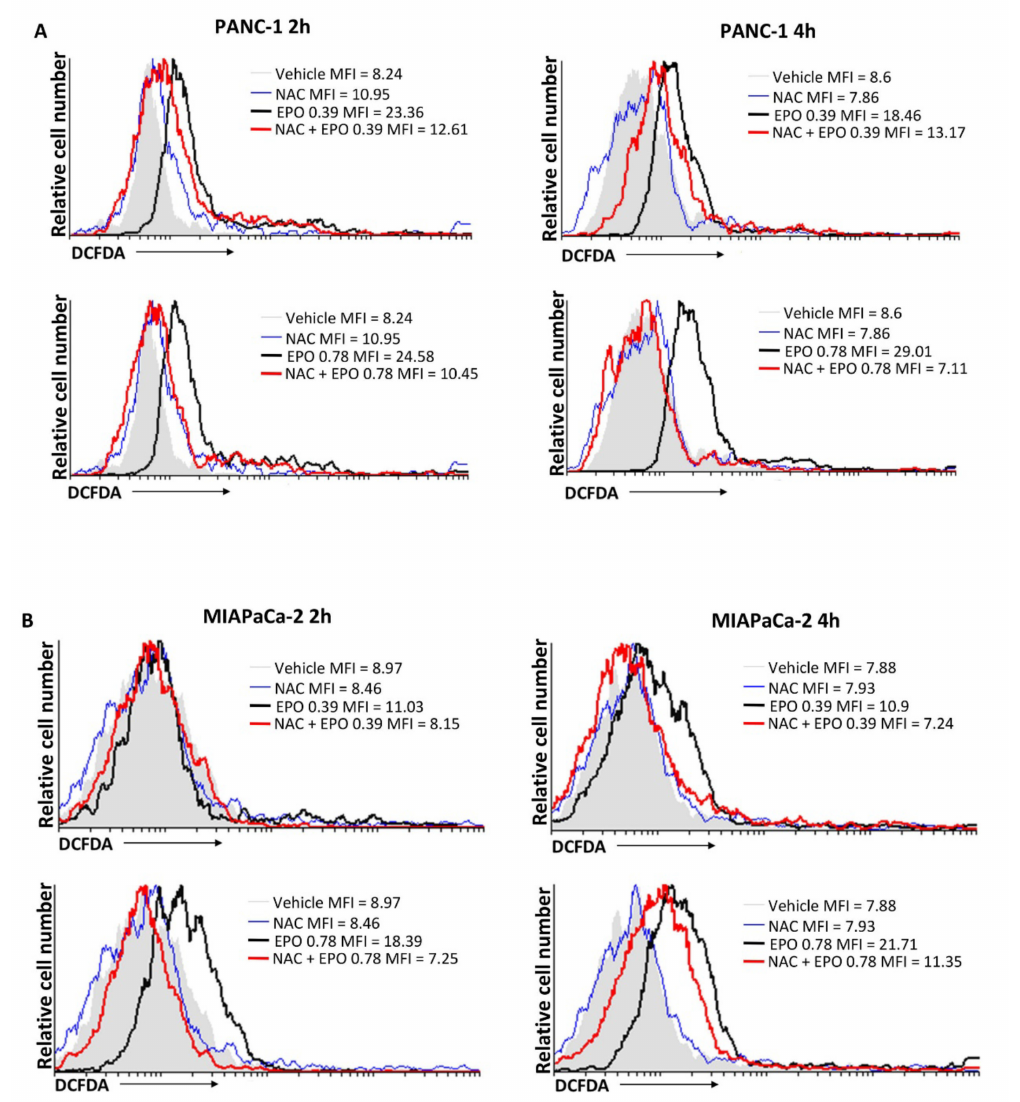
Figure 4. EPO effect on ROS production in ( A ) PANC-1 and ( B ) MIAPaCa-2 cells after 2 and 4 h of treatment. Results are expressed as the mean fluorescence intensity